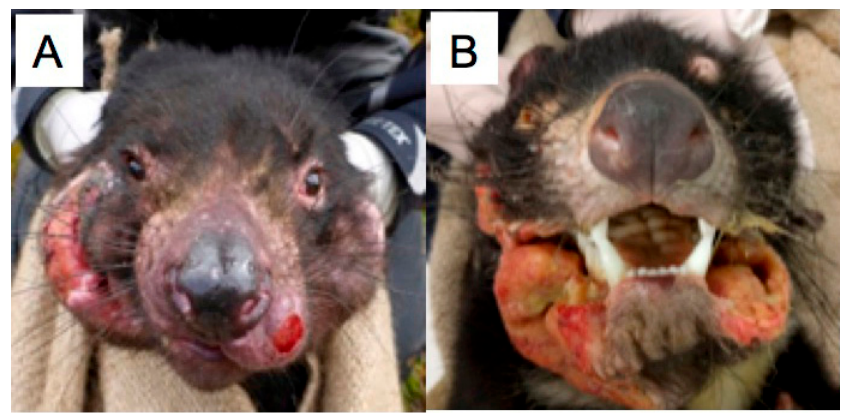
Figure 1. Gross facial deformities caused by ( A ) devil facial tumor disease 1 (DFT1) and ( B )